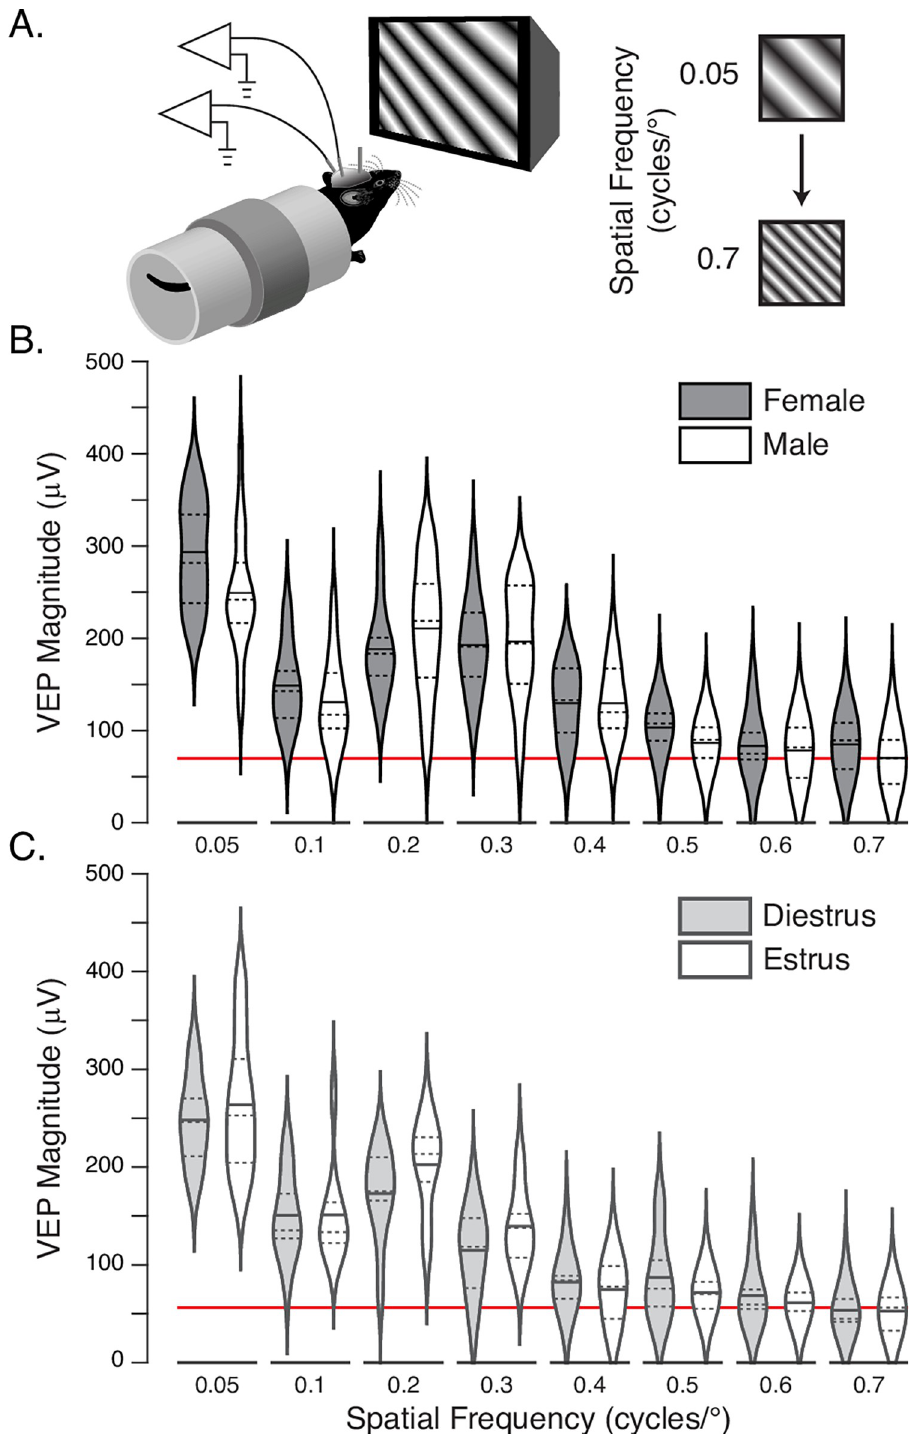
Fig 1. Visual acuity as measured by VEPs is comparable in female and male mice. A. Local field potentials are recorded from head-fixed mice (left) while they view phase-reversing sinusoidal gratings with spatial frequencies varying from 0.05–0.7 (right). B . Violin plots (dashed lines mark quartile boundaries and solid horizontal lines show the mean) showing the peak-to-peak magnitude of VEPs recorded in female (shaded) and male (white) mice as a function of spatial frequency. The red line marks the approximate noise-level recorded absent visual stimulation. C. The same as in B, but for female mice in either estrus (shaded) or diestrus (white). There is no effect of either sex or stage (see main text for statistical